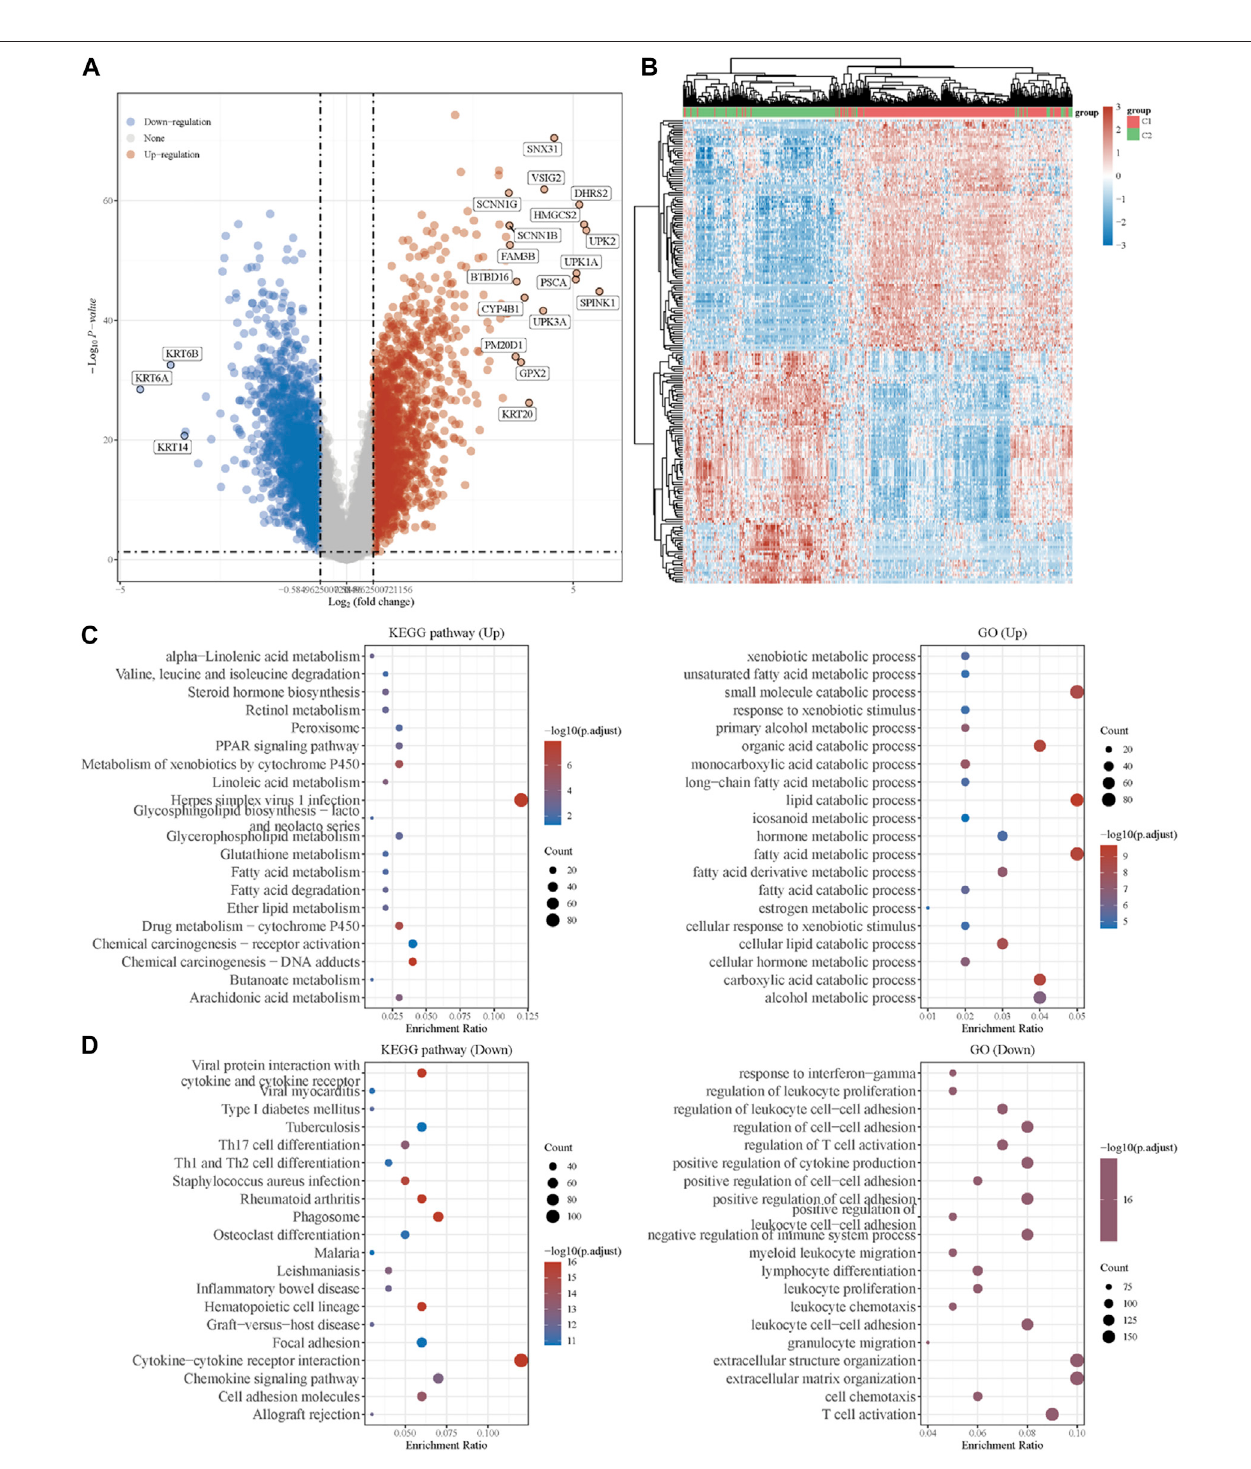
FIGURE2| Identi fi cationofDEGsbetweenthetwoclustersgroupedbyenergymetabolism-relatedgenesetandfunctionalenrichmentanalysis. (A) Volcanoplotof DEGs betweentwoclusterswithdifferentmetabolicstatuses. Thered andblue pointsrepresentup- anddownregulatedgeneswithstatisticalsigni fi cance, respectively. (B) Heatmap ofthetop 50up- and downregulated geneswiththe mostdifferential changes. (C) GO/KEGG analysisofDEGs thatwereupregulated incluster 1. (D) GO/ KEGG analysis of DEGs that were downregulated in cluster 1. DEG: differentially expressed genes.